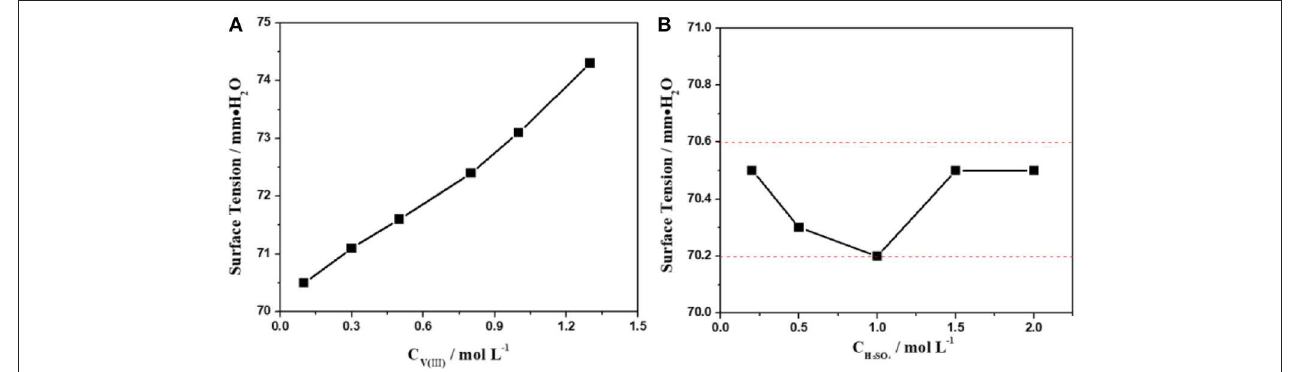
FIGURE 1 | Changes in the surface tension with different concentrations of V(III) (A) and H 2 SO 4 (B)